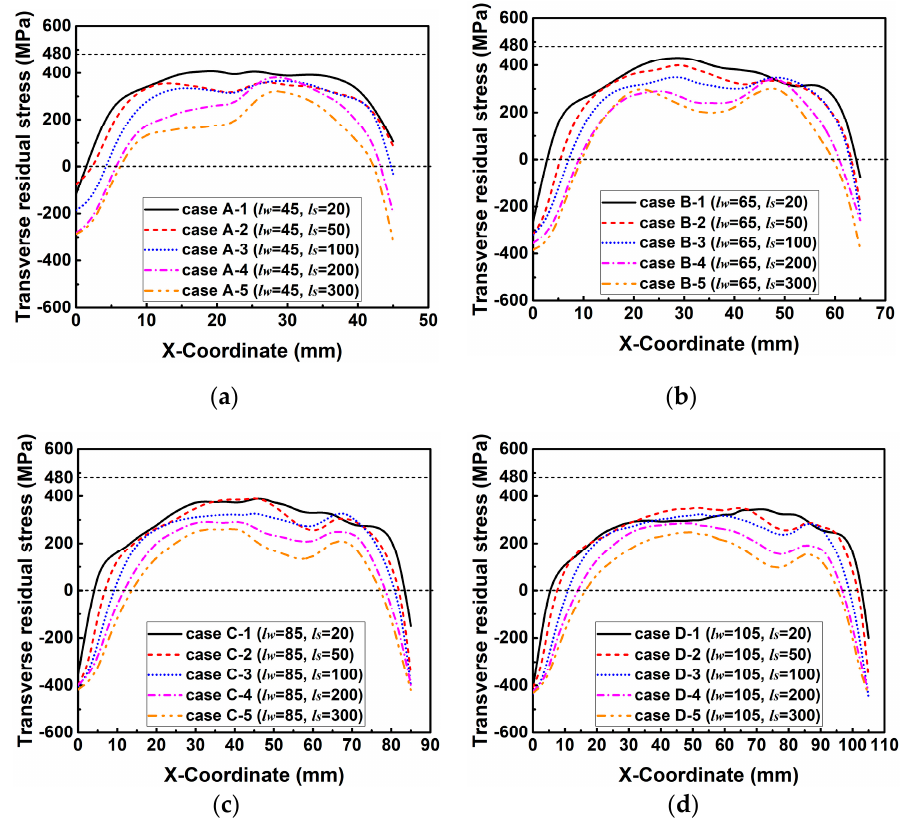
Figure 16. Transverse residual stress distributions along line 2 in the cases of each group with varied slit length ( l s ) while the weld length ( l w ) is kept constant: ( a ) Group A; ( b ) group B; ( c ) group C; ( d ) group D.